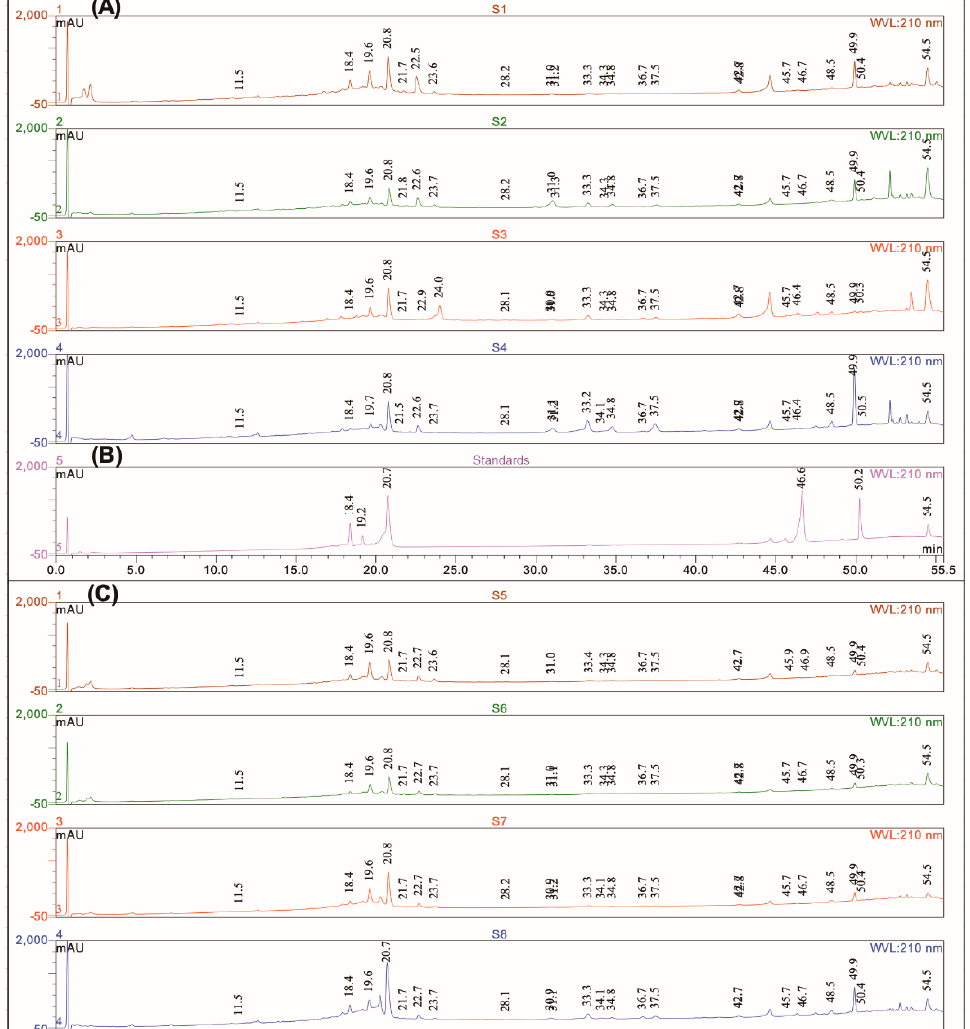
Figure 1. Compounds identification at 210 nm: Profiles of extracts of S. officinalis from Orsomarso: ( A ) S1, S2, S3, and S4. ( B ) The mixture of standards is obtained by diluting to one fifth of the solution initially prepared: Luteolin-7-glucoside (0.052 g/L, retention time (Rt) = 18.4 min), rosmarinic acid (0.194 g/L, Rt = 20.7 min), rutin (0.032 g/L, Rt = 19.2 min), carnosol (0.102 g/L, Rt = 46.6 min), carnosic acid (0.082 g/L, Rt = 50.2 min), and ursolic acid (0.142 g/L, Rt = 54.5 min). Profiles of S. officinalis extracts from Civita: ( C ) S5, S6, S7, and